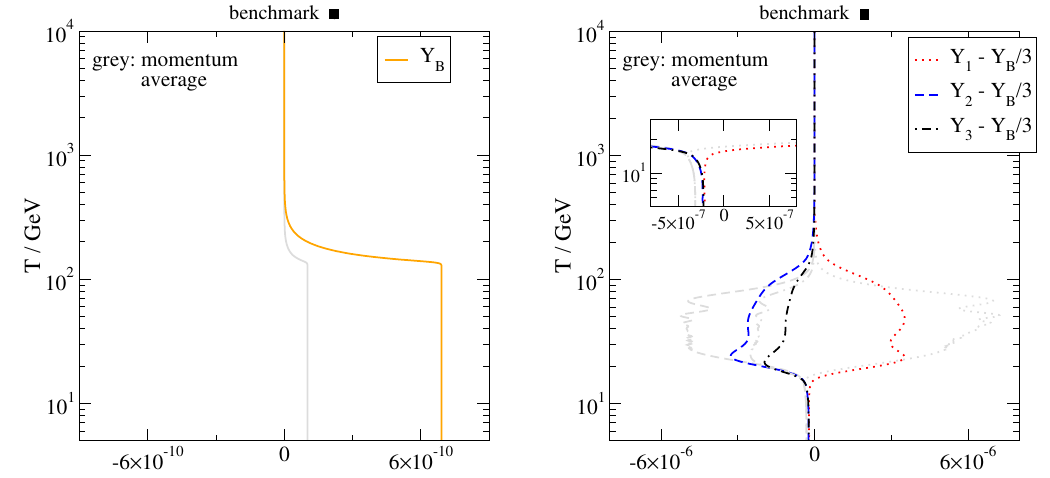
Figure 3 . Left: baryon yield as a function of T= GeV for the benchmark point de(cid:12)ned in section 9. Grey lines show the outcome if we resort to momentum averaging, like in (cid:12)gure 1. Right: the corresponding Y (cid:0) Y = 3. Momentum averaging underestimates Y a B Y (cid:0) Y = a B